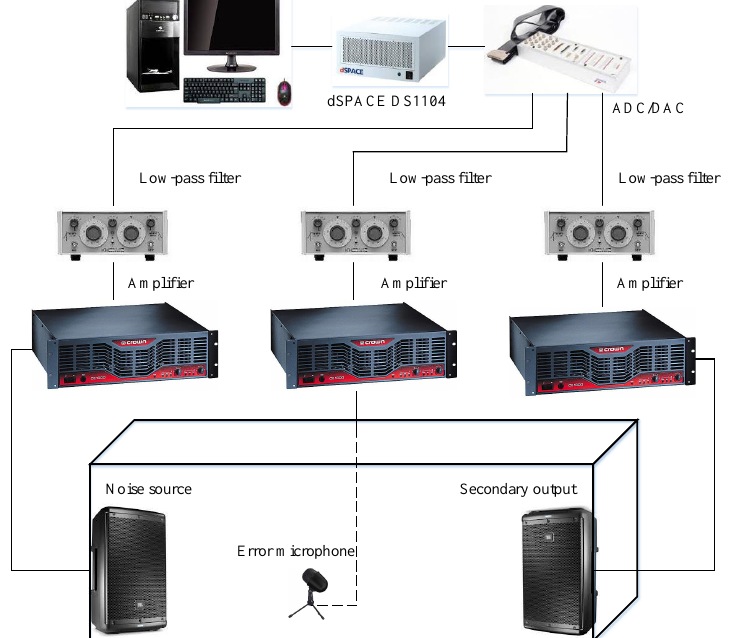
Figure 6. Connection diagram of experimental setup.